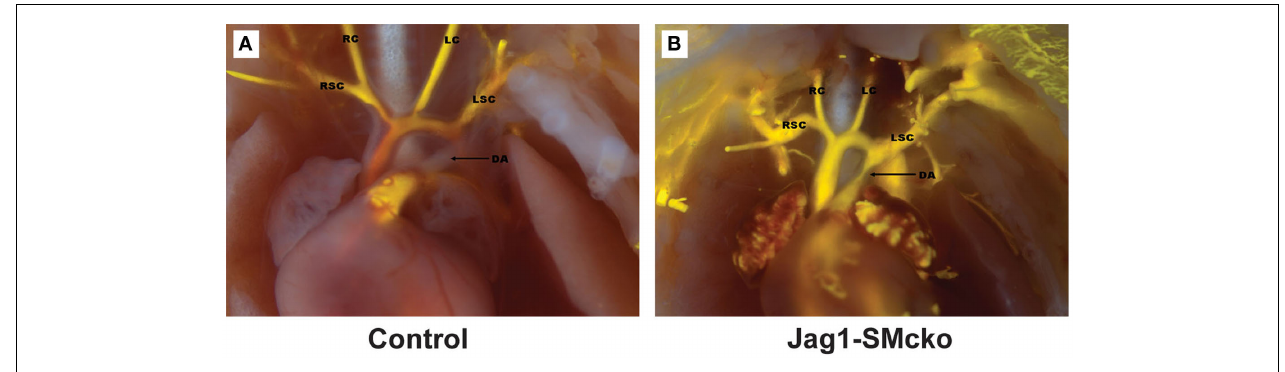
silicone rubber injection compound (tinted yellow).While the ductus arteriosus closed normally in the control mouse, it remained patent (open) in the Jag-1 smooth muscle deletion mouse. Associated defects inVSMC differentiation were also observed. DA, ductus arteriosus; LC, left carotid artery; LSC, left subclavian artery; RC, right carotid artery; RSC, right subclavian